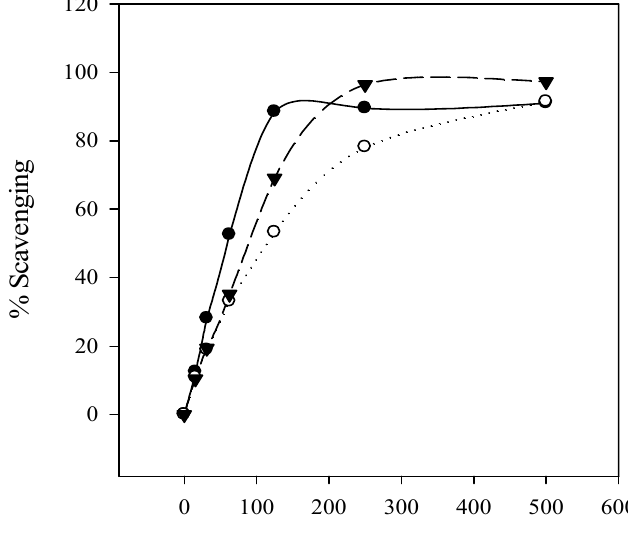
Antioxidant concentration ( μ